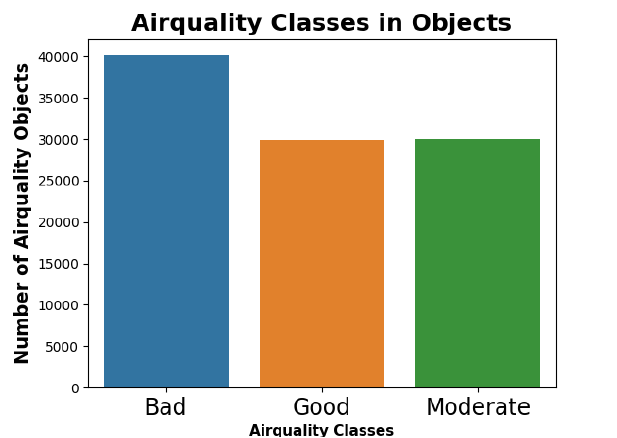
Figure 6. Air Quality Status Types.